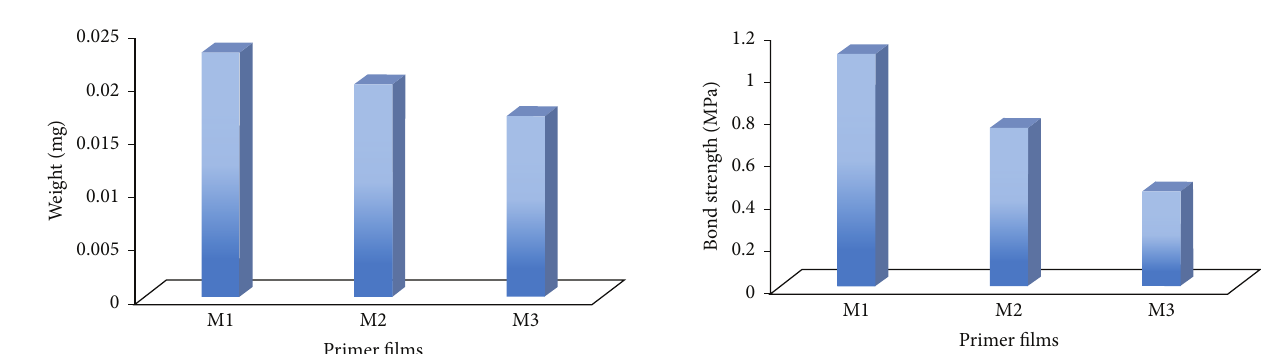
65 wt.% of 2-EHA. Pot life and cure time of acrylic syrups are affected by mass of the mixed